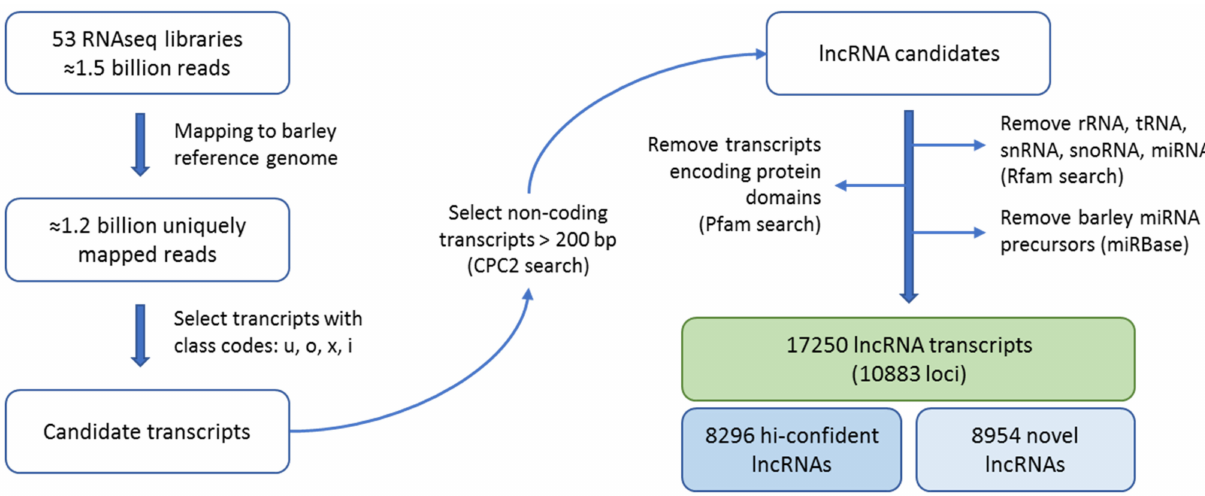
Figure 1. Schematic representation of the procedure used for identification of barley